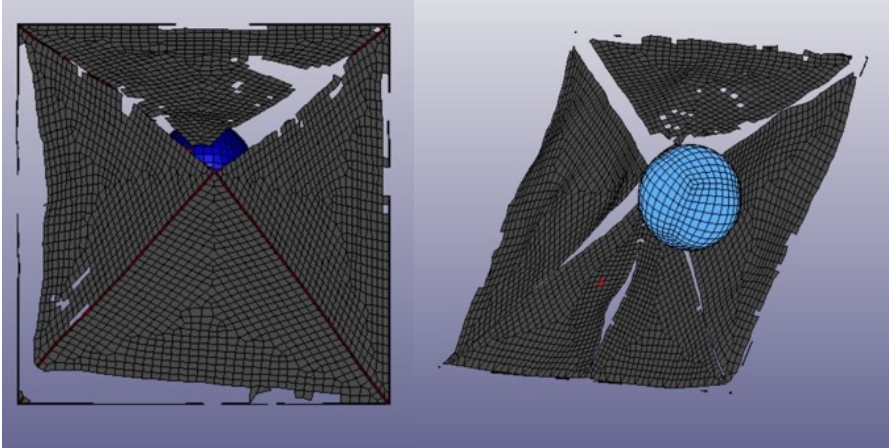
Figure 13. Four Petals Asymmetric VS Five Petals Asymmetric: Impact Simulation.